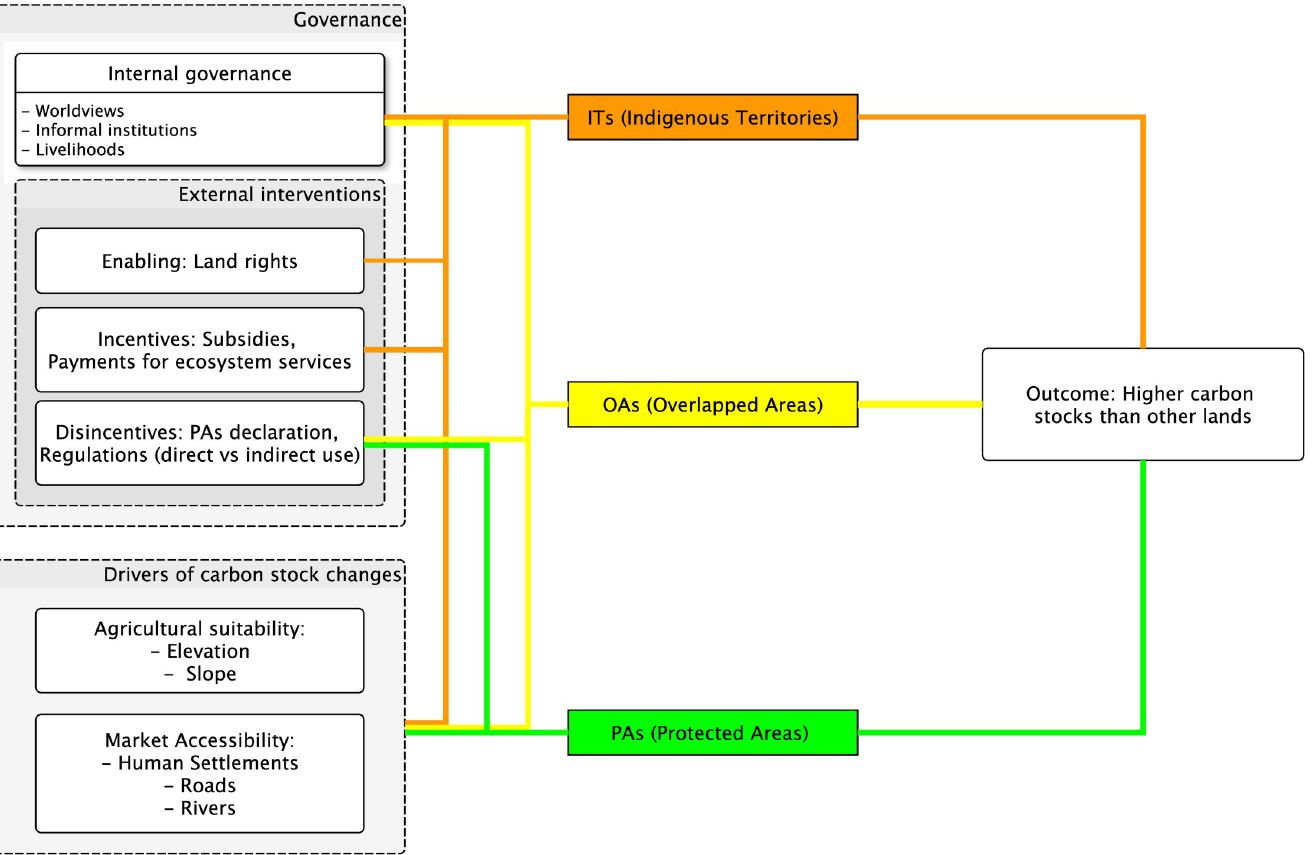
Fig 1. A generic theory of change for land tenures effects on carbon stocks. The lines symbolize hypothetical pathways of how governance components and drivers of carbon stocks change influence ITs (orange), OAs (yellow), PAs (green) to result in an expected outcome.